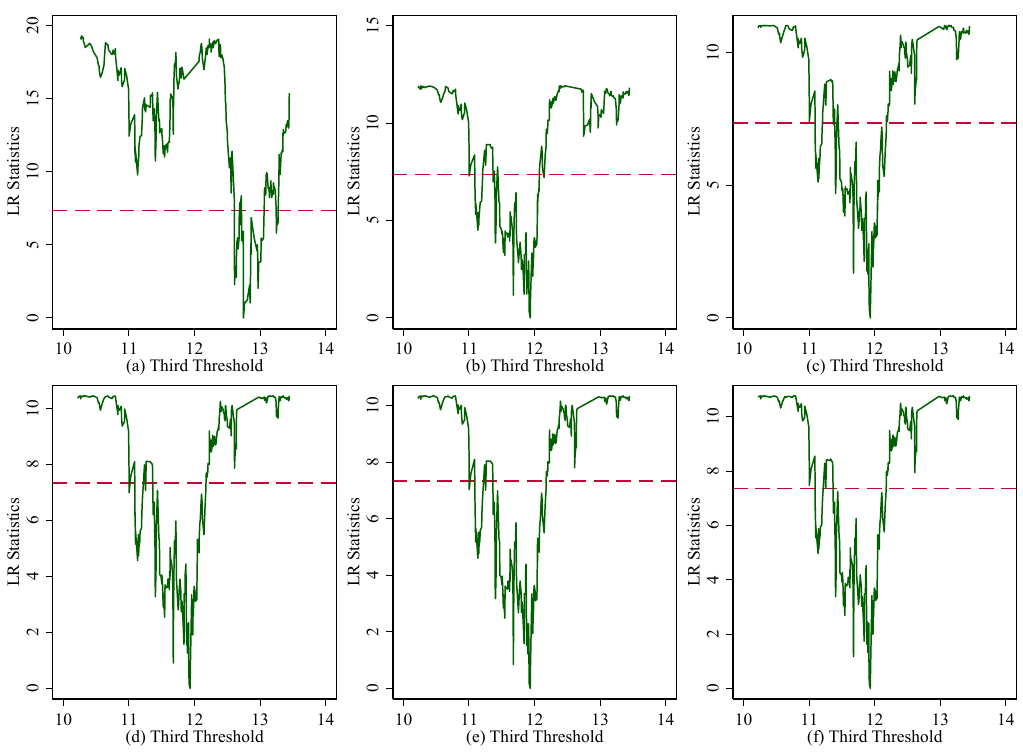
Figure 7. Results of LR test for omitted variables. Note: The graphs were created by the author using Stata 17.0. Notes: ( a ) shows the LR test with the addition of FDI ( fdi ); ( b ) shows the LR test with the addition of per capita GDP ( pcgdp ) on the basis of ( a ); ( c ) shows the LR test with the addition of patent licensing ( patlic ) on the basis of ( b ); ( d ) shows the LR test with the addition of technology-market turnover ( techcon ) on the basis of ( c ); ( e ) shows the LR test with the addition of environmental treatment investment ( pollucon ) on the basis of ( d ); and ( f ) shows the LR test with the addition of industrial structure ( iu ) on the basis of ( e